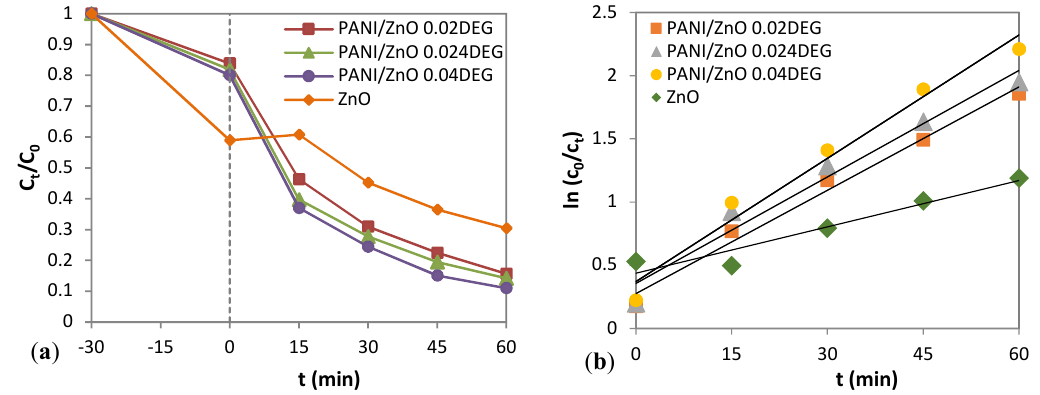
Figure 6. ( a ) Photodegradation of acid blue (AB25) dye under solar irradiation, ( b ) linear plots of ln (c/c 0 ) versus irradiation time.